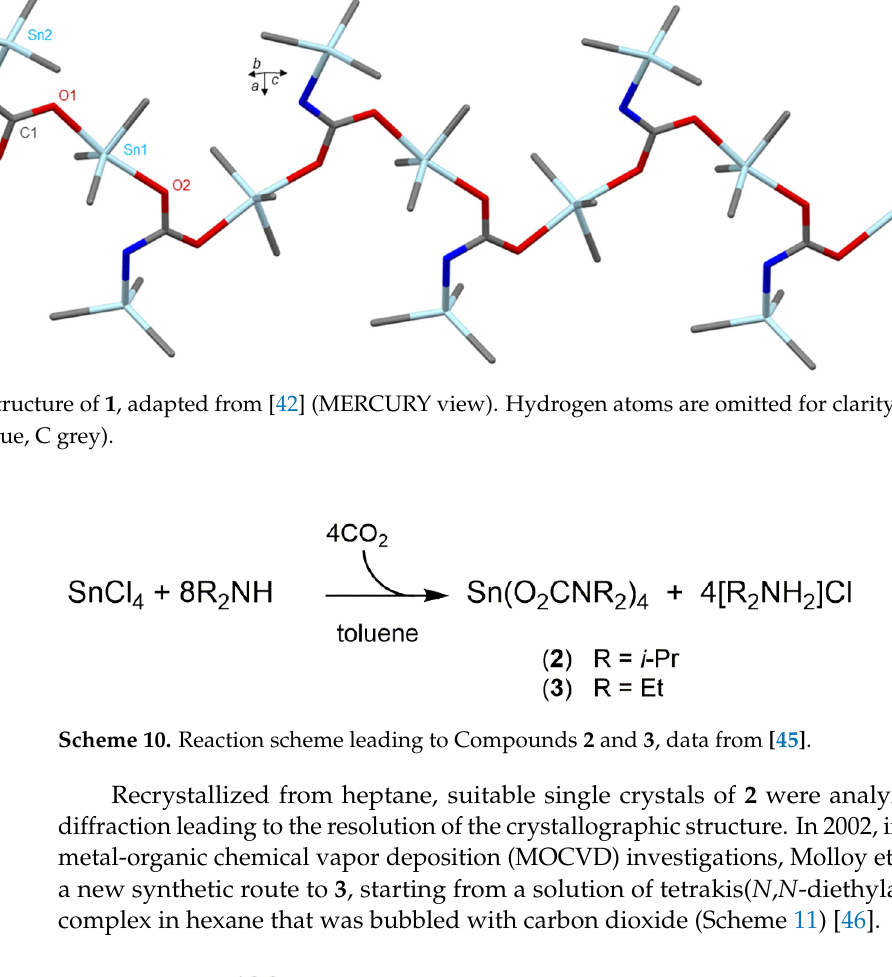
Figure 1. Molecular structure of 1 , adapted from [42] (MERCURY view). Hydrogen atoms are omitted for clarity (Sn light blue, O red, N dark blue, C grey).